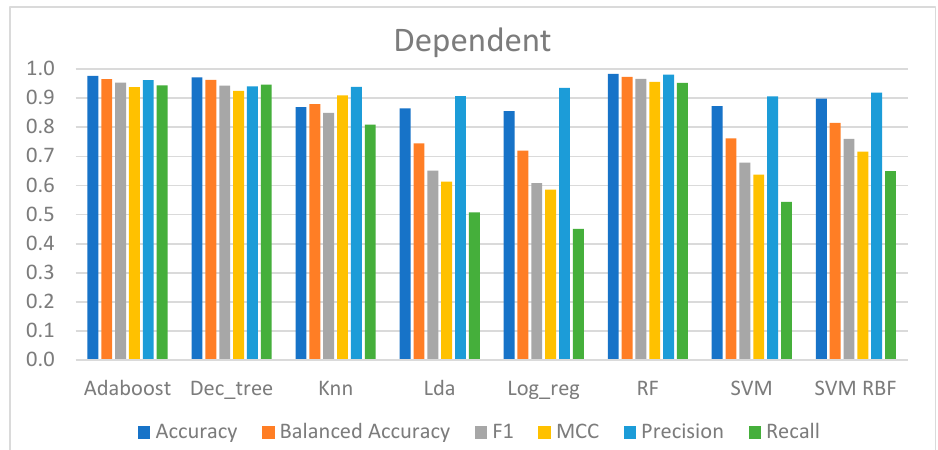
Figure 8. Metrics for performance evaluation of the dependent approach.